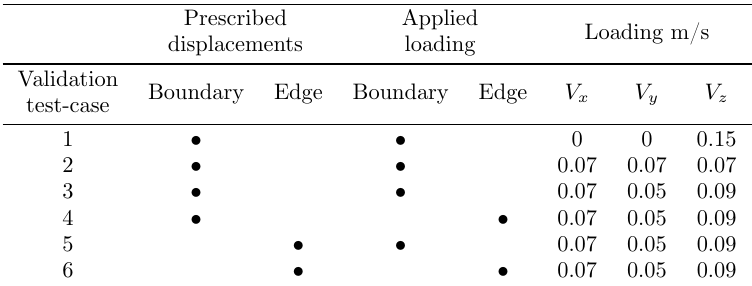
Table 1. Validation